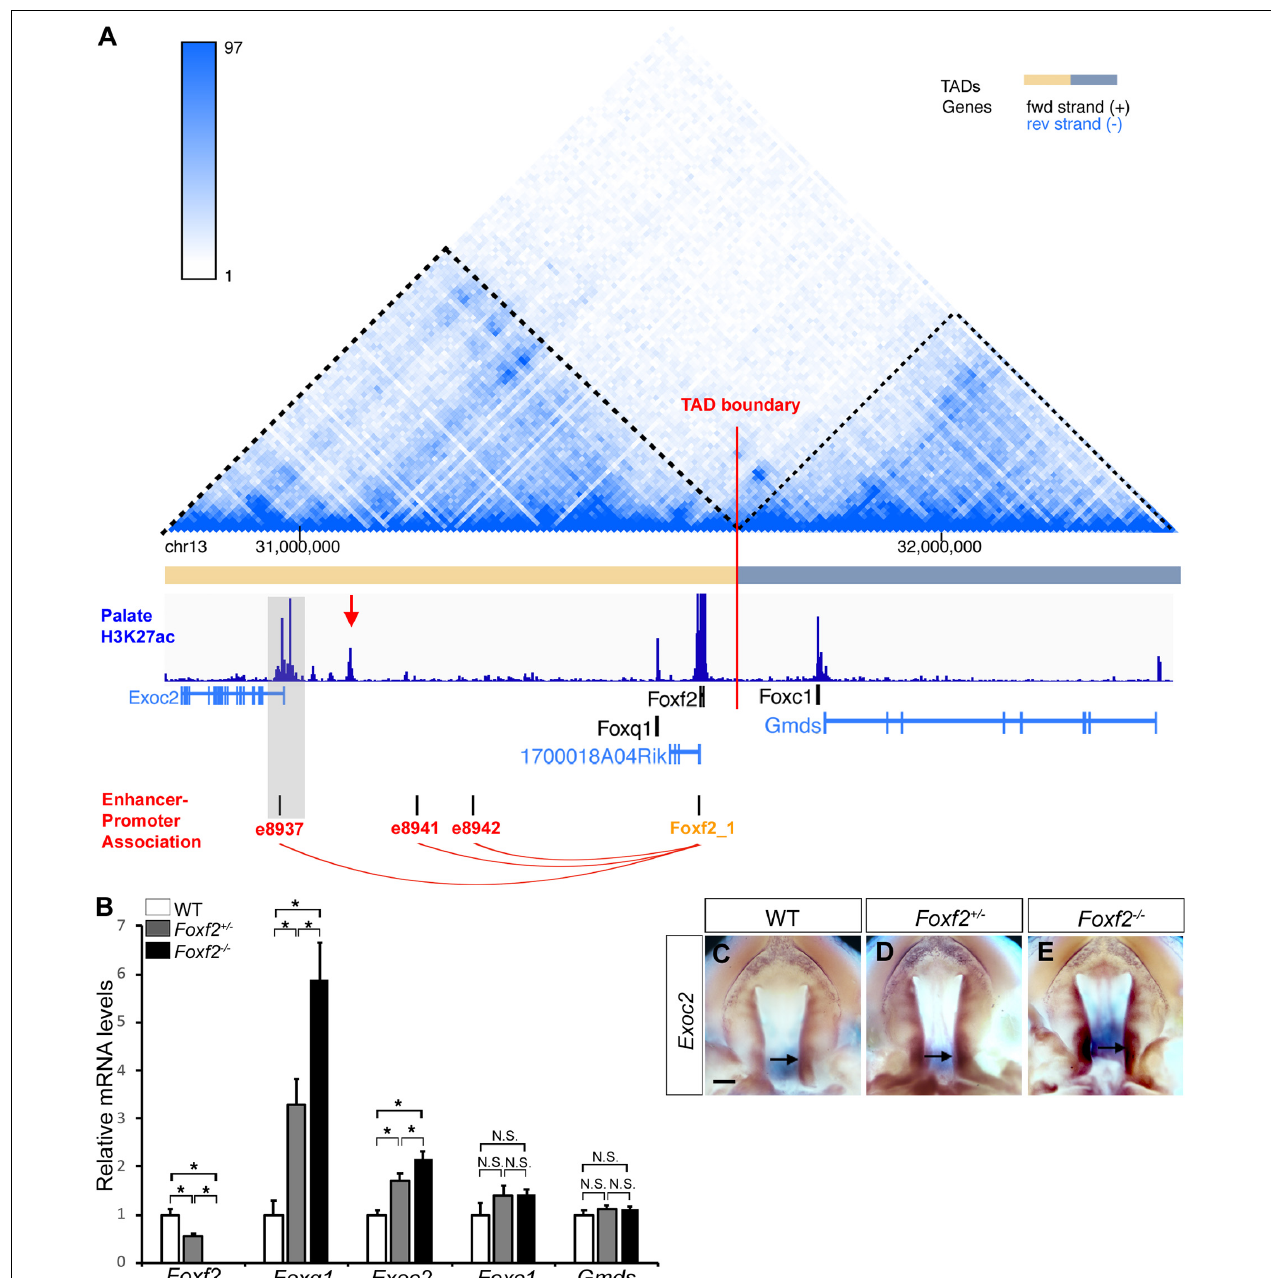
FIGURE 3 | Analysis of genome organization around the Foxf2 - Foxq1 gene cluster and the effect of the Foxf2 mutation on expression of neighboring genes in palate development. (A) Hi-C map and histone H3K27ac ChIP-seq peaks in the genomic region containing the Exoc2 , Foxq1 , 1700018A04Rik , Foxf2 , Foxc1, and Gmds genes (Chr13: 30,790,000-32,370,000). The top panel shows the chromatin interaction frequency heatmap from Hi-C analysis of mouse embryonic stem cells (3dgenome.fsm.northwestern.edu) (Bonev et al., 2017; Wang et al., 2018). The color of the heatmap indicates the level of normalized interaction. The identified topological association domains (TADs) are indicated by orange and gray color, respectively. The middle panel shows histone H3K27ac ChIP-seq peak signal plot in deep blue color [data from Xu et al. (2019)]. A red arrow points to a highly enriched H3K27ac peak in the intergenic region between Exoc2 and Foxq1 . Transcription orientation of the genes is indicated by black (“ + ” strand) or blue color (“-” strand). The bottom panel shows the replicated associations between enhancers and the Foxf2 gene promoter, retrieved from ENCODE3 and EPDnew (https://genome.ucsc.edu). Three enhancers (e8937, e8941 and e8942) were annotated to show replicated associations with the Foxf2 promoter in mouse fetal tissues. Note that enhancer e8937 is located in intron-1 of the Exoc2 gene and colocalized with a H3K27ac peak from the E12.5 mouse posterior palatal tissues (highlighted in gray). (B) Real time RT-qPCR analysis of the levels of expression of Foxf2, Foxq1, Exoc2, Foxc1 , and Gmds mRNAs in the E13.5 palatal shelves in wildtype (WT), Foxf2 + / − and Foxf2 − / − embryos ( n ≥ 4). * p < 0.05. N.S., not significantly different. (C–E) Palatal view of whole mount embryonic upper jaws showing Exoc2 mRNA expression in the palatal tissues in E13.5 wildtype (WT) (C) , Foxf2 + / − (D) , and Foxf2 − / − (E) embryos. Arrow points to posterior region of the palatal shelves. Scale bar, 400 µ m.